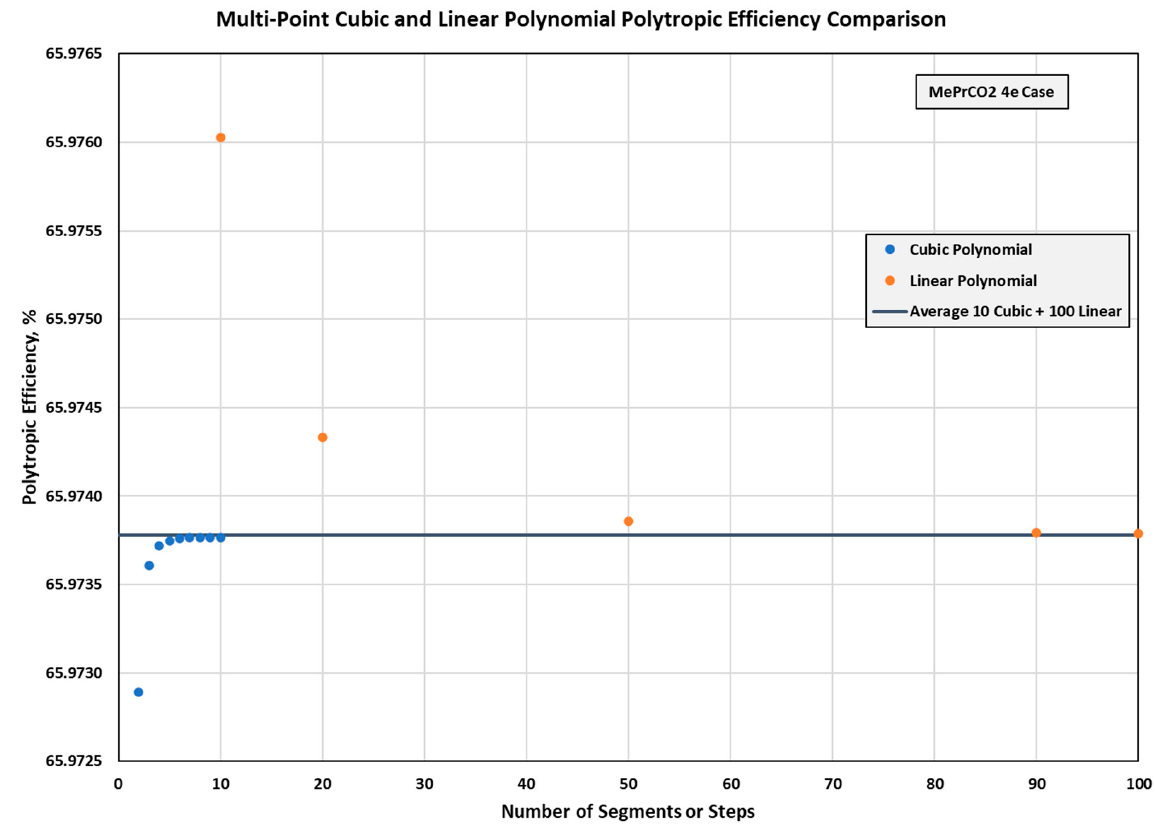
Figure A8. Asymptotic approach to a solution.